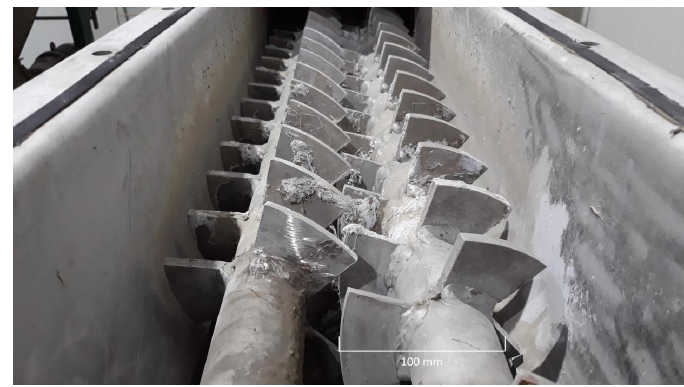
Figure 1. Inside view of the screw feeder SOFRADEN MPS120.